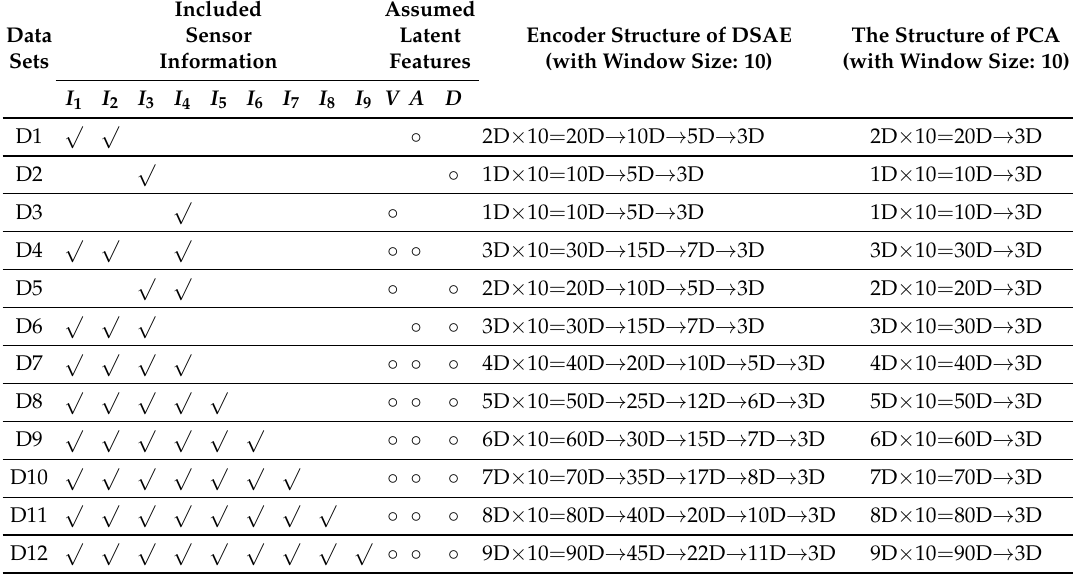
Table 2. Sensor information included in the 12 datasets we prepared and the PCA and DSAE designs for each of